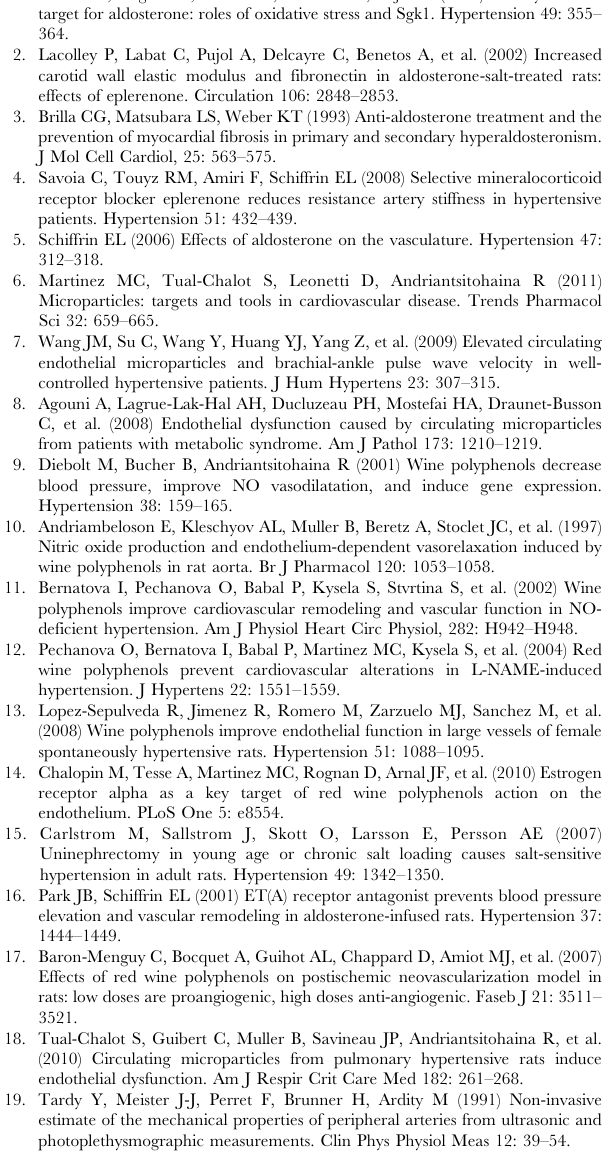
Figure S1 Carotid artery incremental elastic modulus- wall stress (Einc- WS) curves. A. Einc-WS curves from Control, Spironolactone (Spiro) and Provinols TM (Prov) rats (n =5–9 for each group). B. Mean value of WS at 1500 kPa of Einc. Values are means 6 SEM. Figure S2 NO production in aorta. Quantification of the amplitude of NO-Fe(DETC)2 signal (amplitude per mg of dried